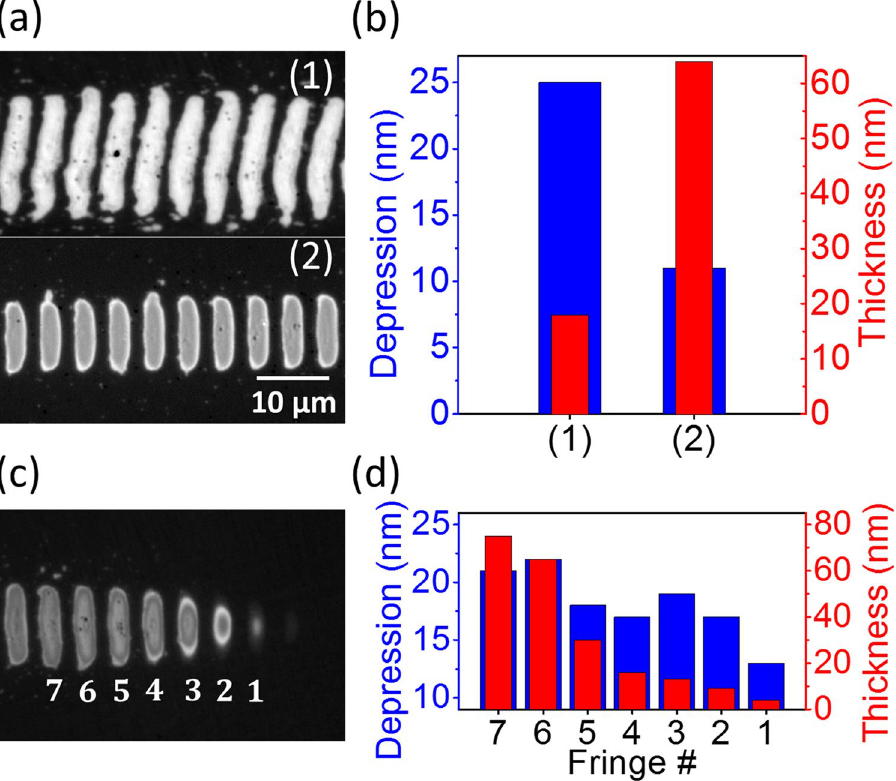
Figure 7. ( a ) Optical micrograph of two lines of Λ s + fringes written with different effective pulse numbers N eff . For high N eff values the fluence was reduced to prevent ablation. (1) N eff = 158 , F = 120 mJ / cm 2 , (2) N eff = 55 , F = 140 mJ / cm 2 . ( b ) Representation of the surface depression and thickness of the fringes shown in ( a ). ( c ) End of a line of fringes written. The effect of progressive fringe length shrinking is caused by closing the laser shutter, while the sample was moving from right to left. ( d ) Representation of the surface depression and thickness of the fringes shown in ( c